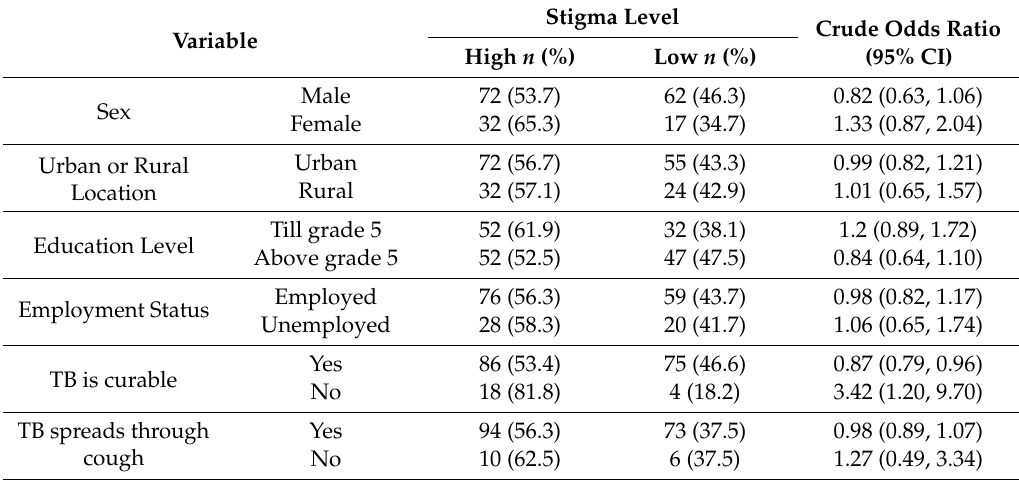
Table 4. Factors associated with perceived stigma about